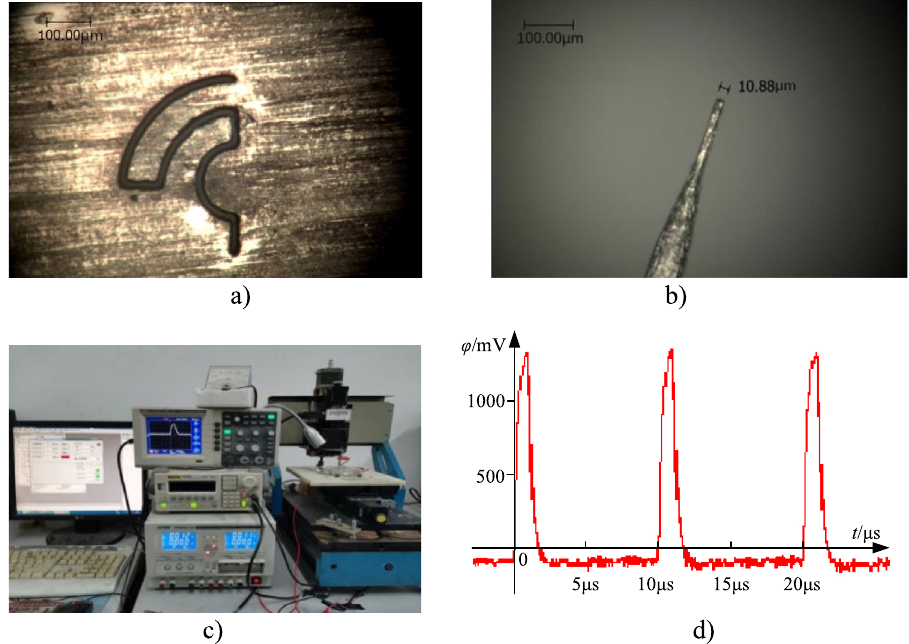
Figure 7. ( a ) Micro double curve beam produced with proposed technique. ( b ) Tool electrode; ( c ) machining system with double feedback circuits. ( d ) Experimental voltage waveform.